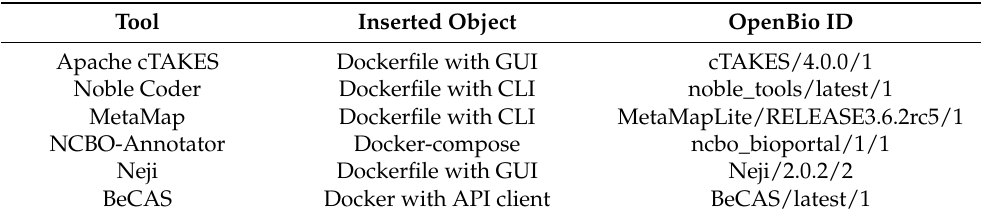
Table 4. BTA Tools imported into OpenBio.eu (with unique OpenBio.eu IDs); all tools were imported in various Docker